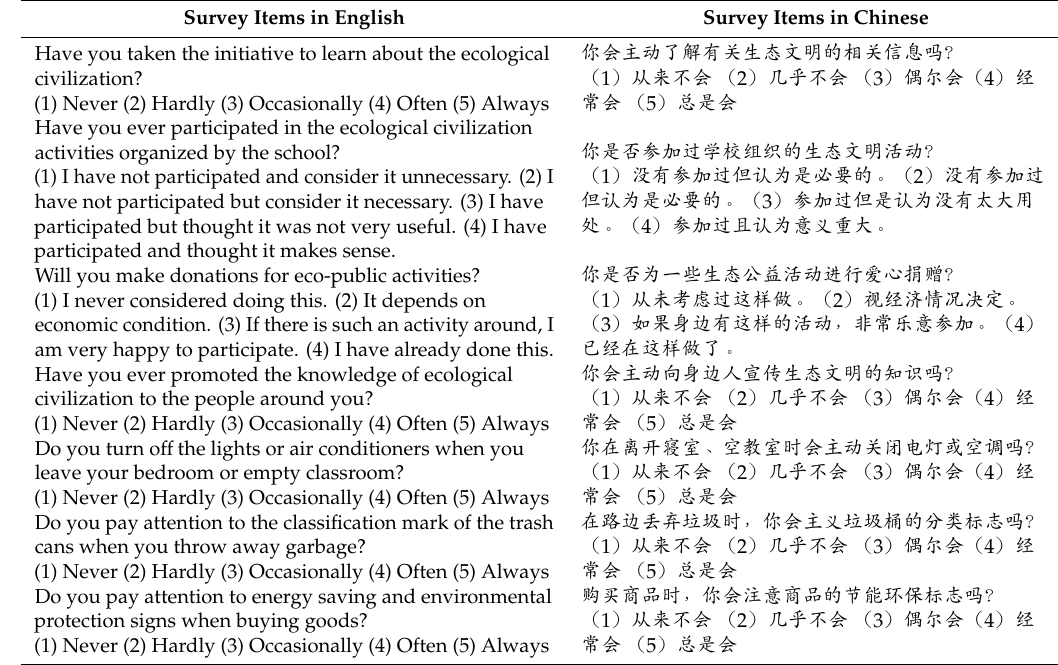
Table A1. Survey Items for Measuring Pro-environmental Behavior.